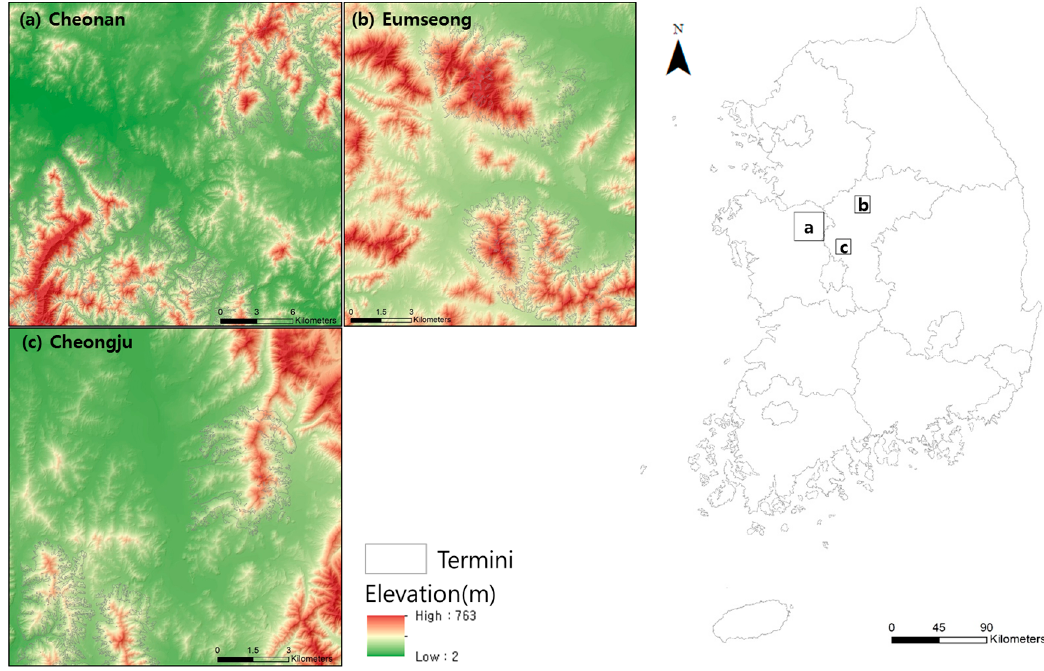
Figure 1. Three study sites in South Korea. ( a ) Cheonan (816 km 2 ); ( b ) Eumseong (236 km 2 ); and ( c ) Cheongju (202 km 2 ).